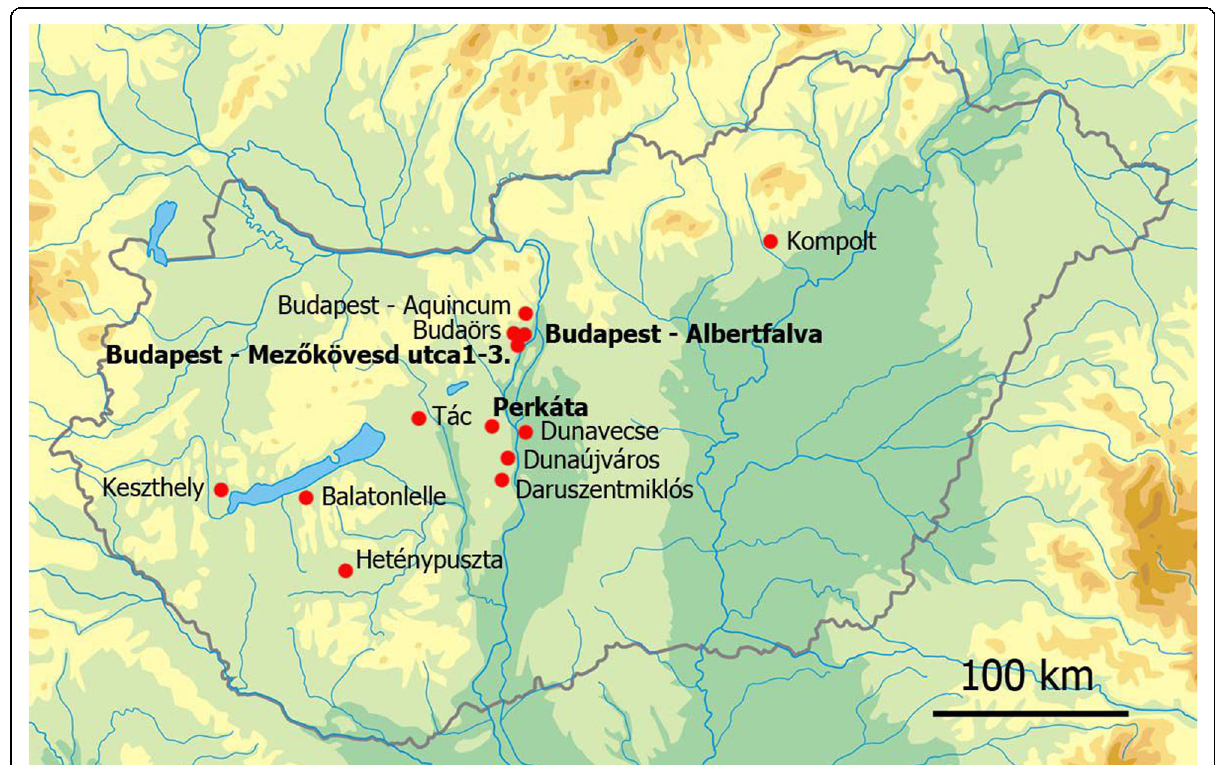
Fig. 1 Camel finds from Roman Period sites in Hungary (Source: Biller,